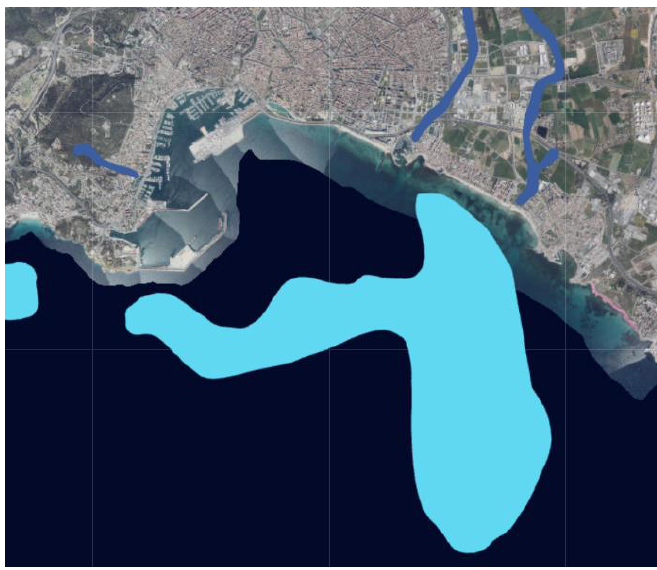
Figure 1. Posidonia meadow (in blue color) close to the construction area.